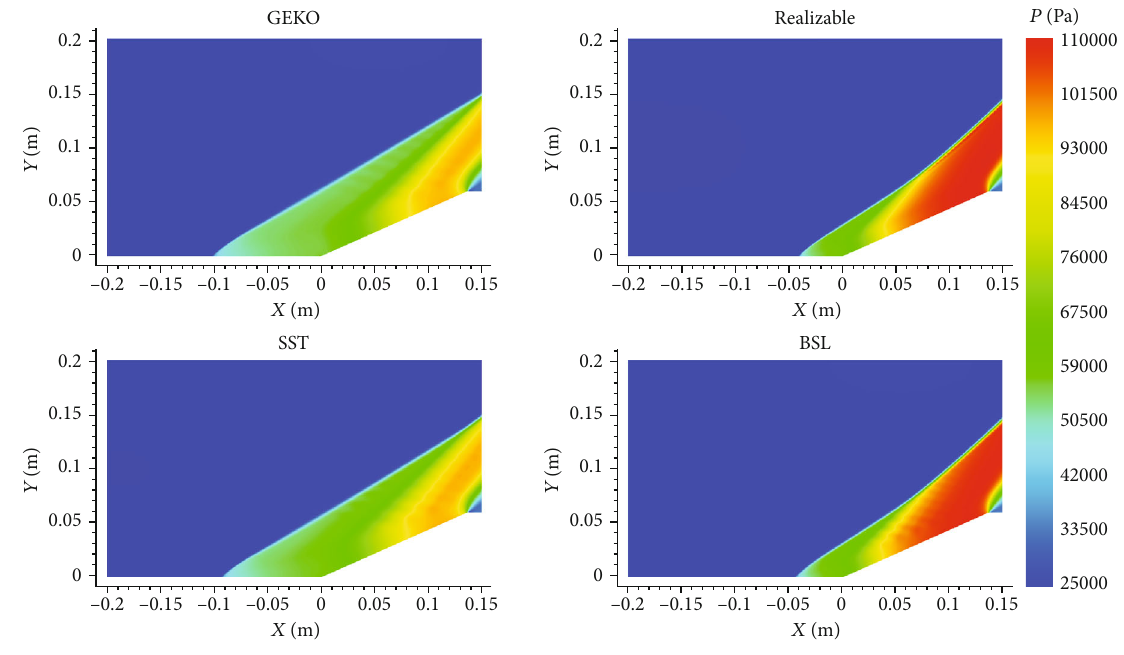
Figure 12: Static pressure contours over the 24-deg compression ramp. Table 9: The number of samples (left) and ϵ (right) for a range of values of the polynomial chaos ð p Þ and oversampling rate ð n p Þ . LOO No. of